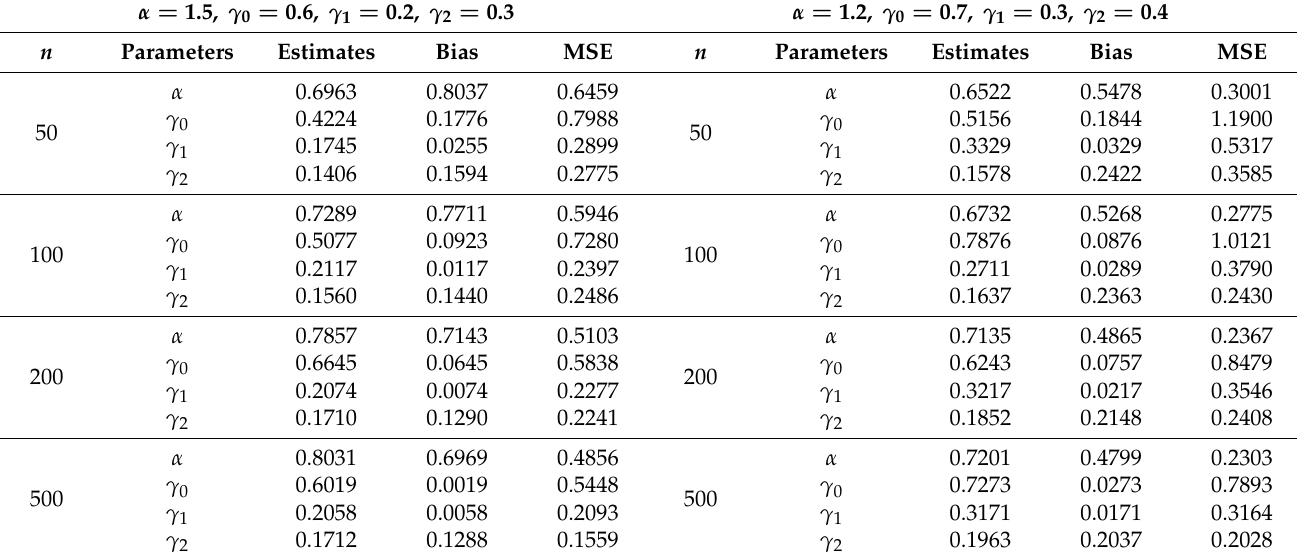
Table 5. Simulation results for the PEE regression